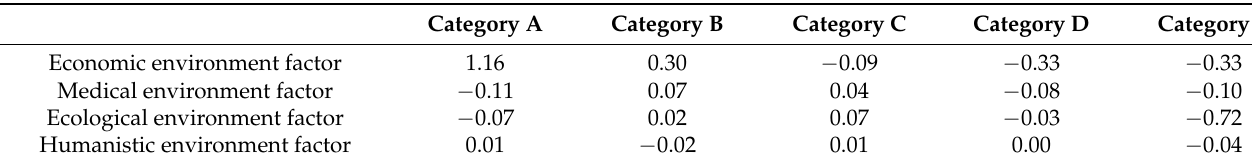
Table 3. Final clustering